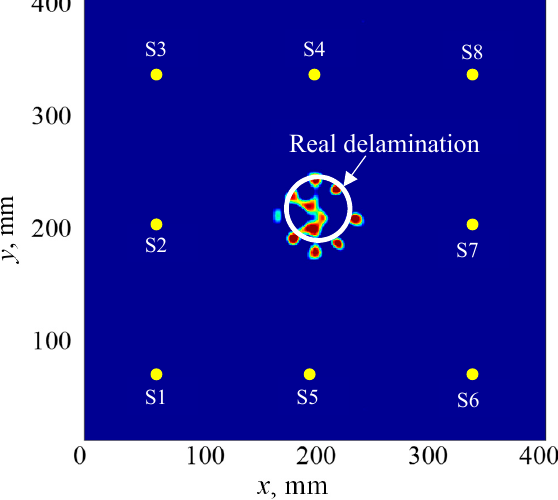
Figure 18. Damage orbit with the transmitter and receiver PWAS as foci.